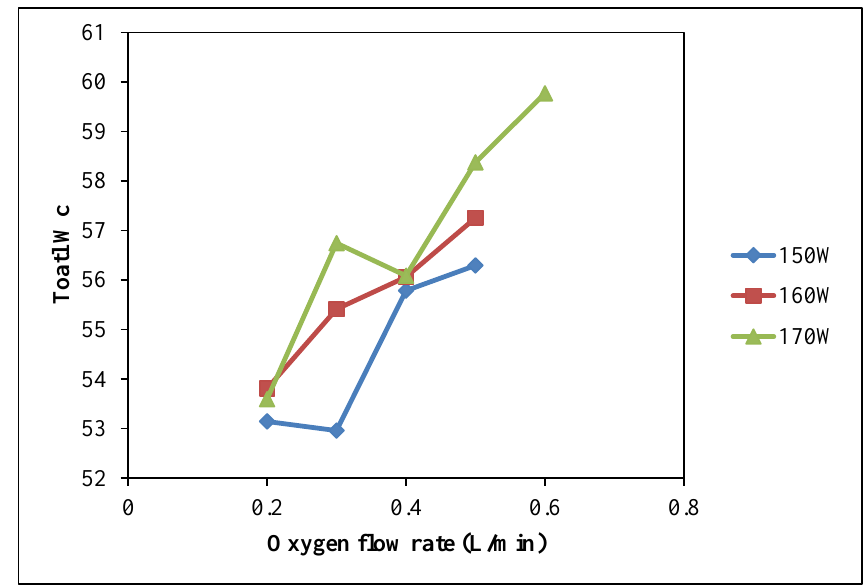
Figure 8. Effect of oxygen flow rate on total W c (Oxygen flow rate: 0.2 L/min, 0.3 L/min, 0.4 L/min, 0.5 L/min and 0.6 L/min; Discharge power: 150 W, 160 W and 170 W; Jet travelling speed: 5 mm/s and Jet-to-substrate distance: 3 mm).